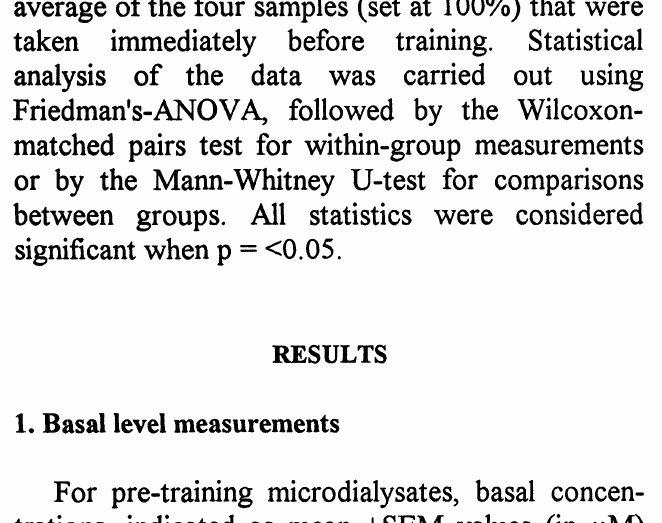
Basal concentrations of amino acids